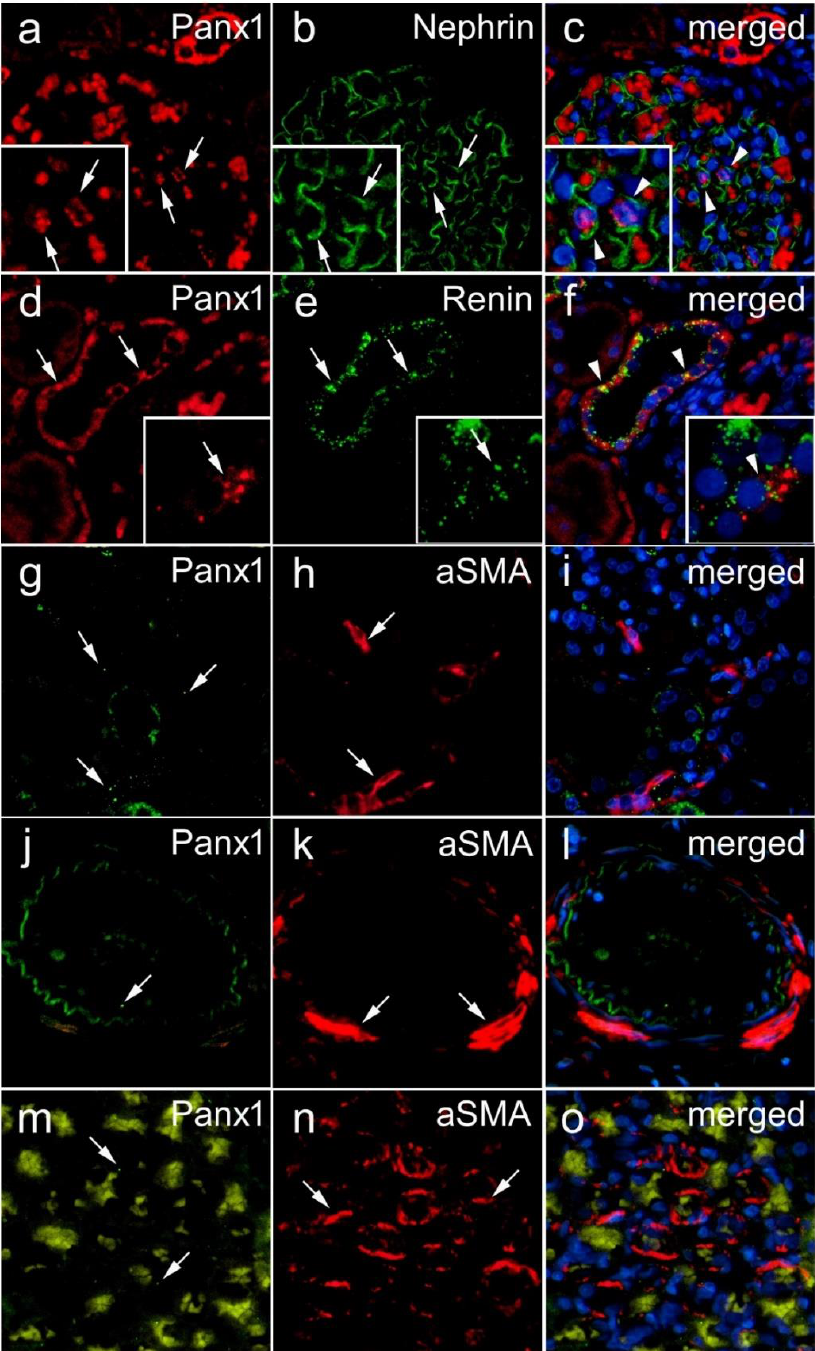
Figure 5. Glomerular and vascular expression of Panx1 in postnatal human kidney. Double